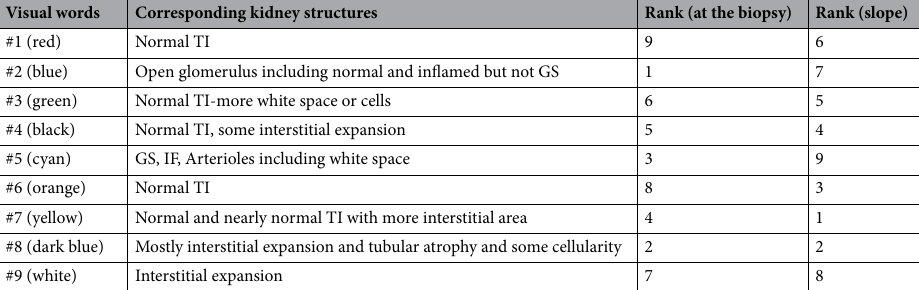
Table 5. Description of 9 representative visual words. TI, tubulointerstitial; GS, glomerulosclerosis; IF, interstitial